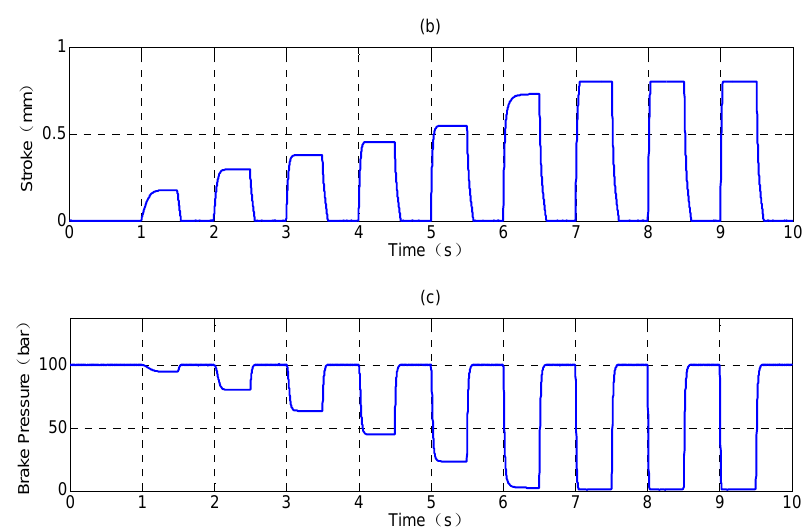
Figure 14. The proportional valve relief simulation in 100 bars: ( a ) step wave command; ( b ) iron core stroke; and ( c ) caliper pressure.